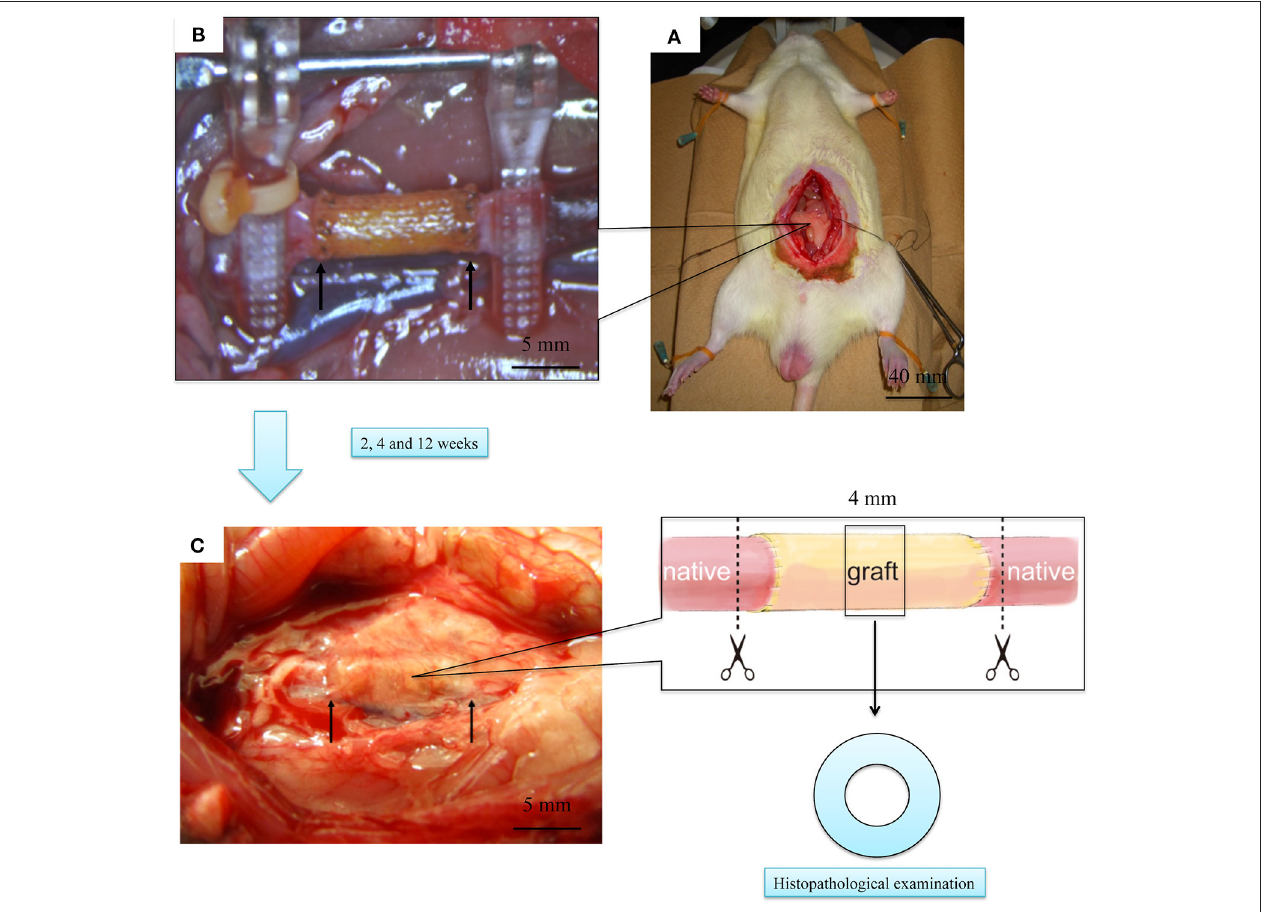
FIGURE 7 | Laparotomy images of the rat implantation experiment of elastin (EL)–silk fibroin (SF) graft. (A) Picture of the graft immediately after transplantation. The two yellow arrows indicate the cranio-caudal anastomosis of the graft. (B) Picture of the rat with open abdomen and transplanted EL–SF graft. (C) Picture of removing artificial vascular graft at 2 weeks after implantation. The grafts, including autologous blood vessels, were removed using scissors at the dotted